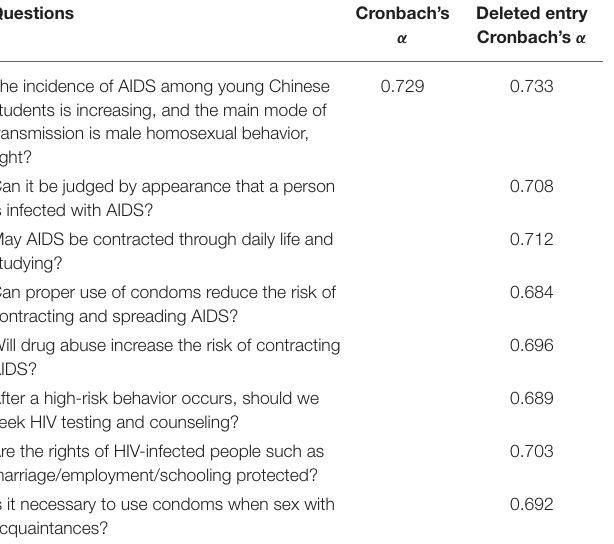
TABLE 2 | The reliability of the questionnaire.